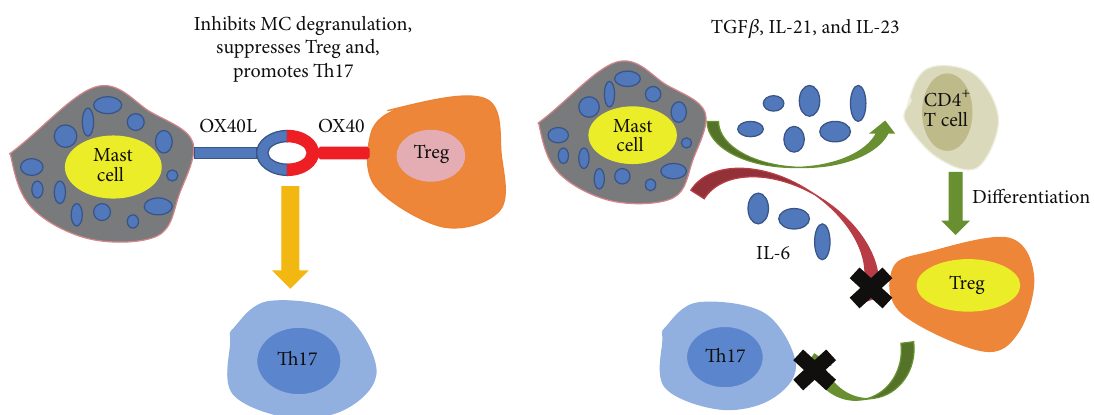
Figure 1: Direct cell interaction between mast cells and T